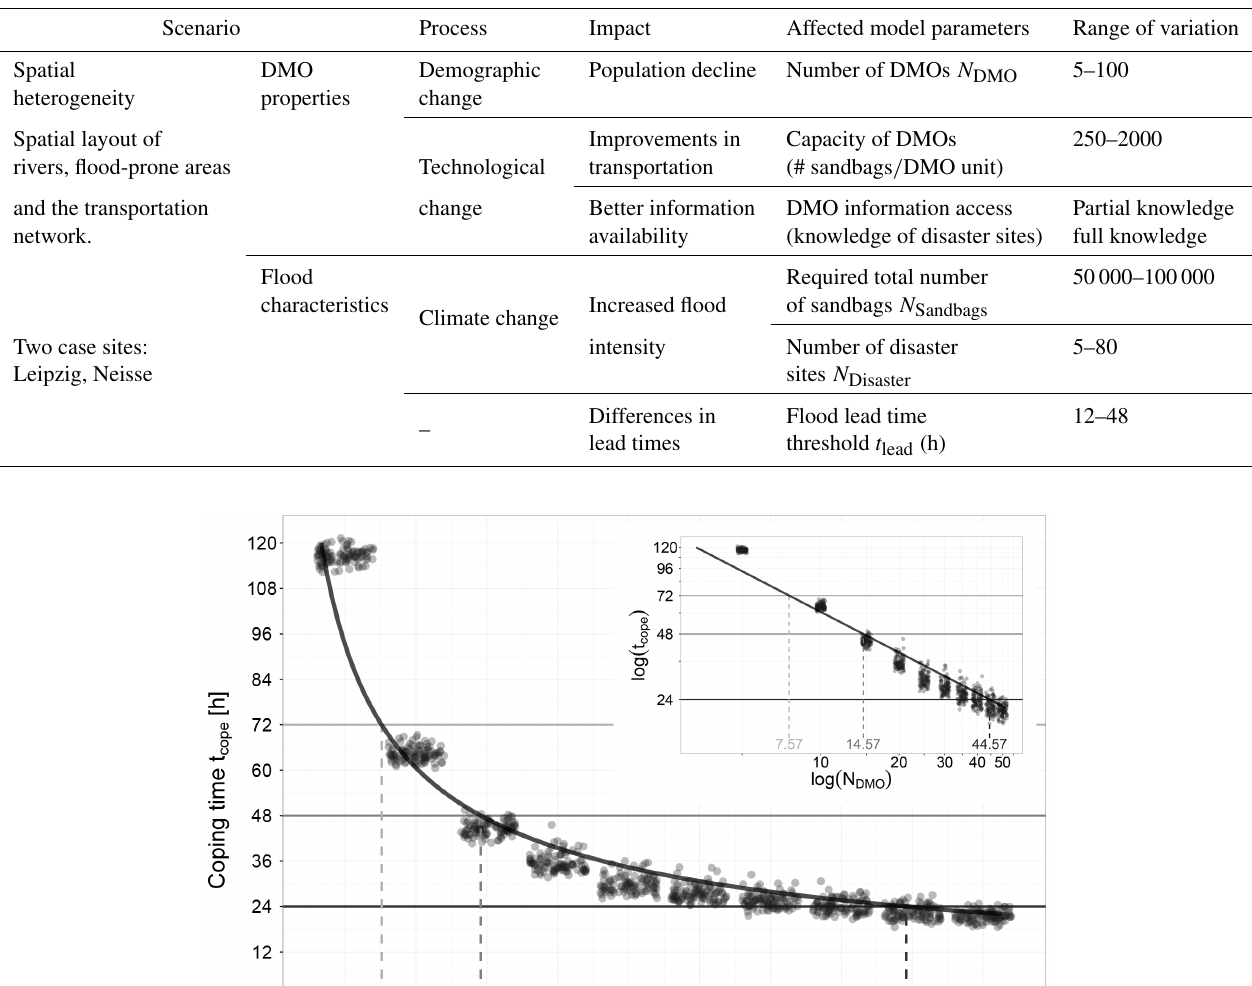
Table 2. Scenario overview, showing change processes, their impact and affected model parameters. All analyses carried out for scenarios (1) and (2) have been carried out for two different spatial settings in scenario (3). Flood lead times represent a flood characteristic; however they are mostly determined by geographical and hydrological settings as well as river morphology, not by climate change. Therefore, no process is associated to it.